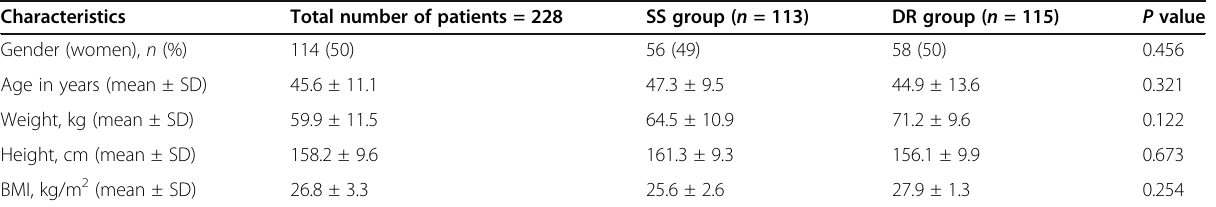
Table 2 Patients ’ demographics Characteristics Total number of patients = 228